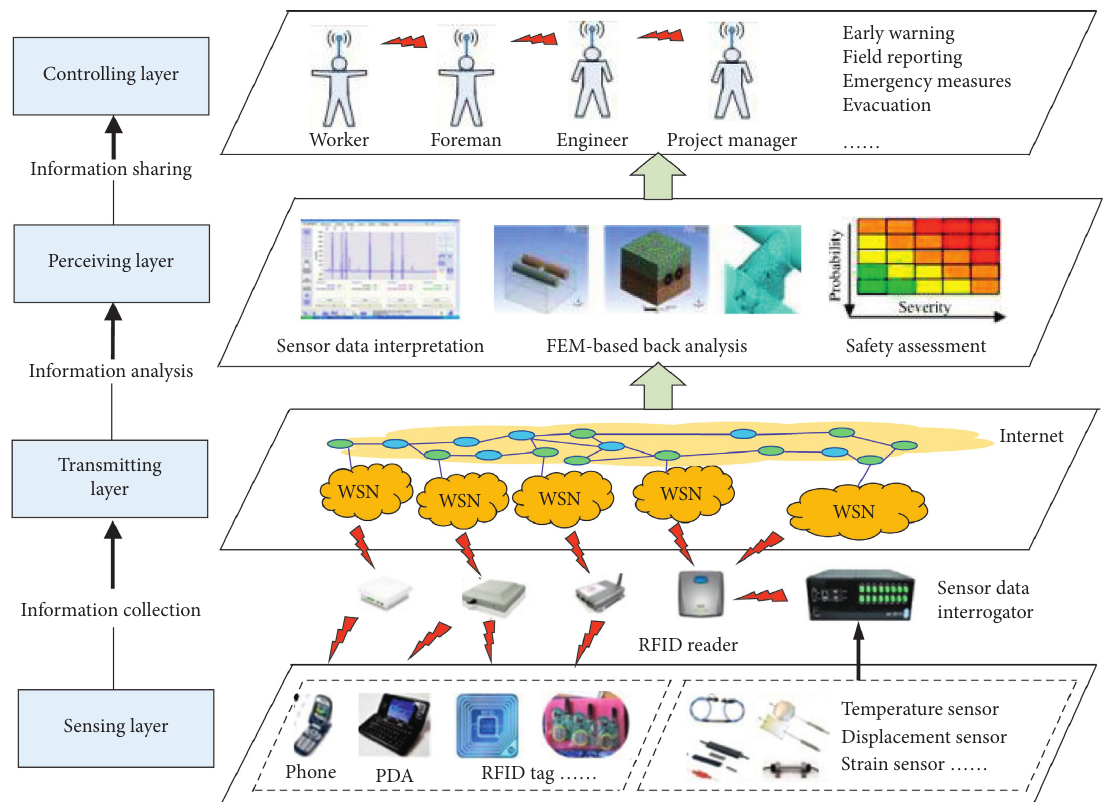
Figure 7: Real-time early warning system for underground construction safety based on Internet of Things